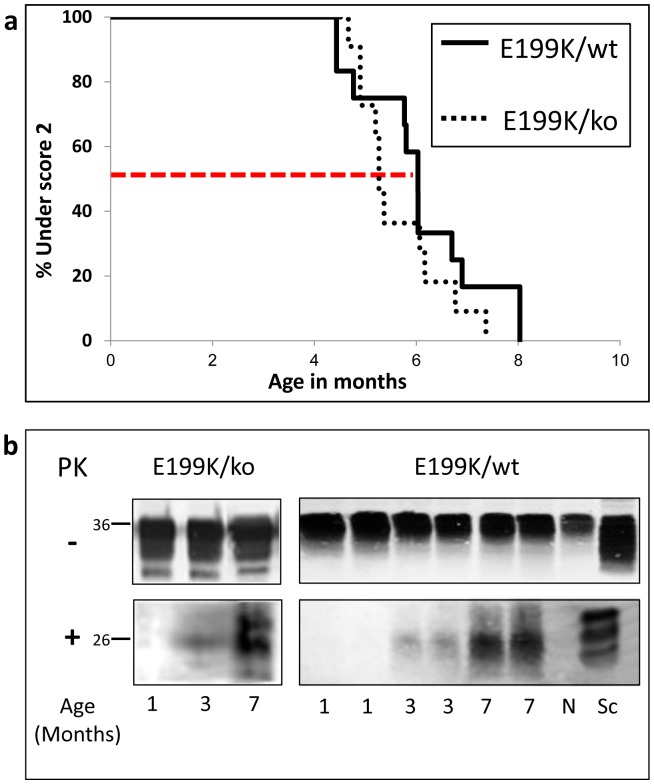
Similar disease kinetics and PrP accumulation in heterozygous and homozygous TgMH2ME199K mice.(a) The percentage of mice presenting a score <2 in both E199K/ko and E199K/wt lines as related to age. Median was 5.2±0.8 for TgMHu2ME199K/ko mice and 6.0±1.2 for TgMHu2ME199K/wt mice. (b) PK-resistant PrP levels are similar in both lines as related to age. Brain homogenates from both TgMHu2ME199K/KO and TgMHu2ME199K/wt lines in different ages and clinical stages (1 month, 3 months and 7 months, score = 0, score = 0 score = 3 respectively) as well as wt and scrapie RML controls were digested with PK and immunoblotted with α-PrP pAb RTC.